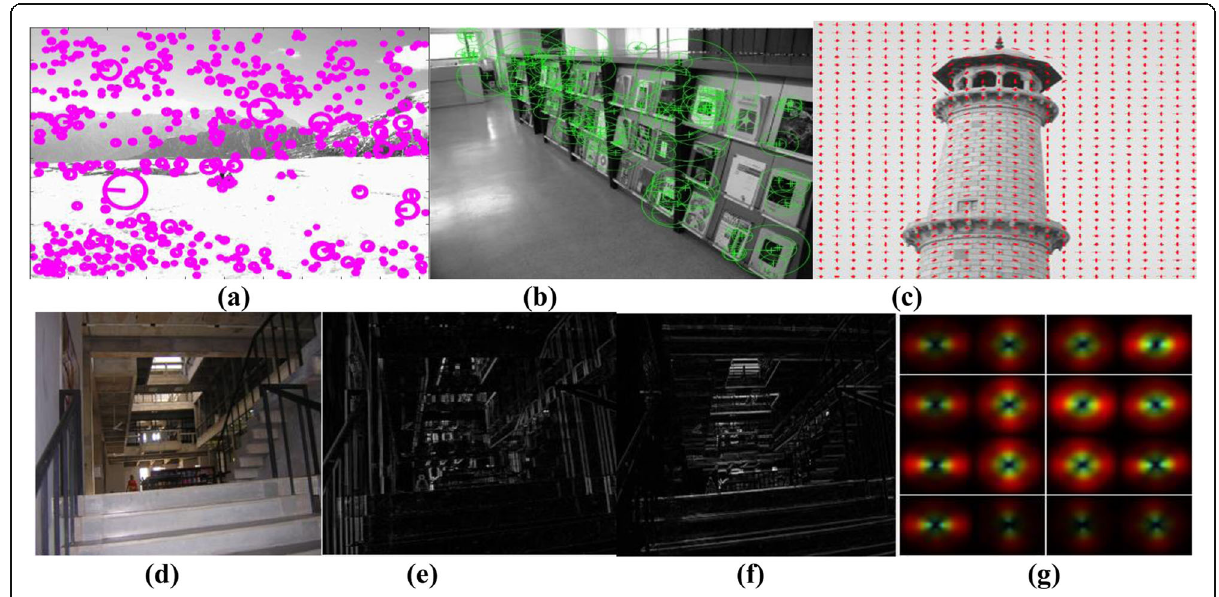
Fig. 2 Illustration of visual descriptors. a Scale-invariant feature transform key points detected in an outdoor image; b Speeded up robust features key points detected in an indoor image; c Histogram of oriented gradients features detected in an outdoor image; d Input indoor image; e Horizontal directional morphological gradient; f Vertical directional morphological gradient; g GIST